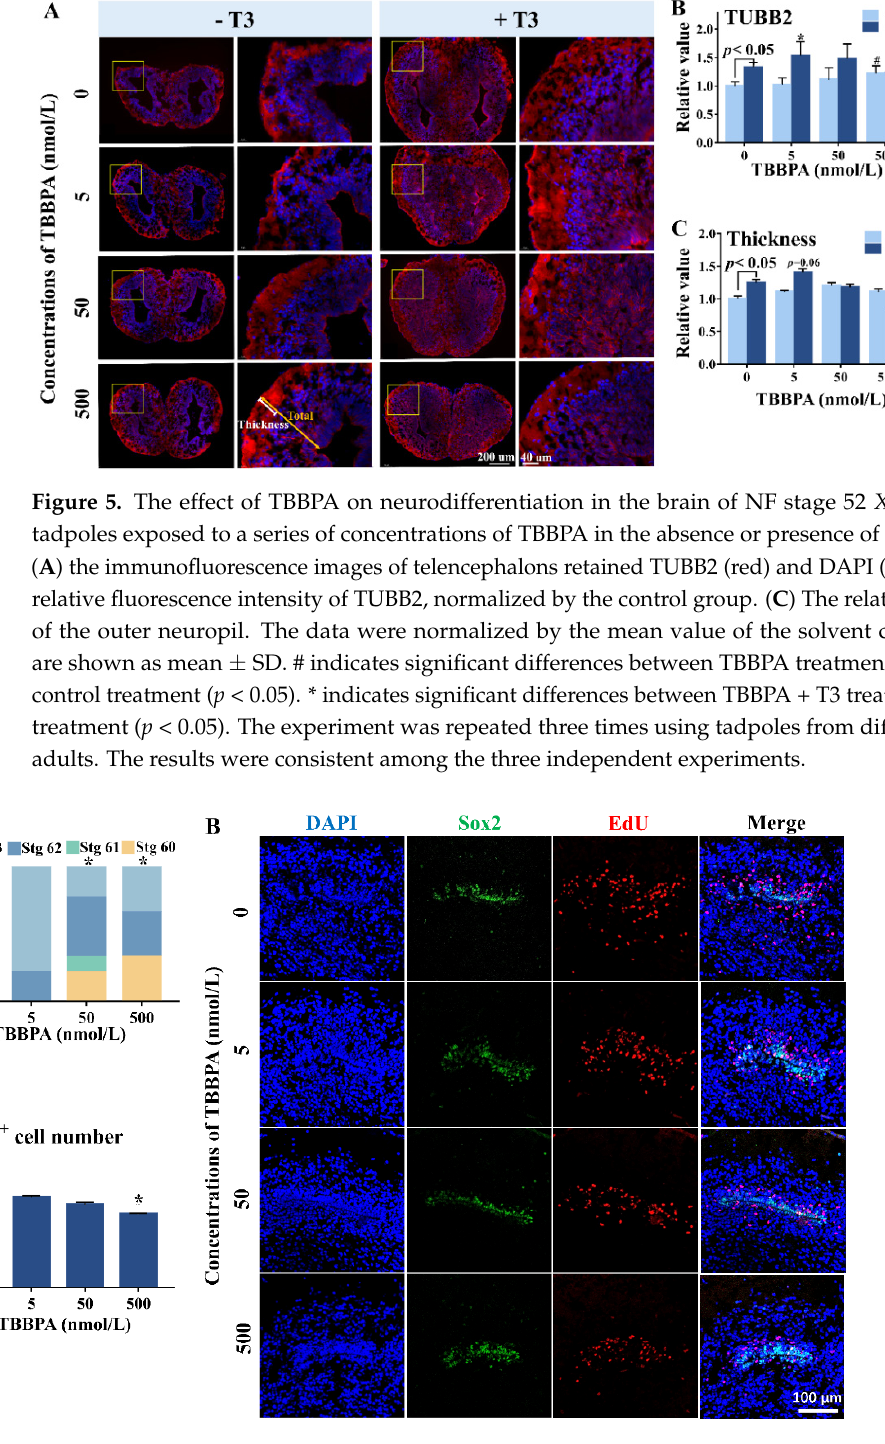
Figure 6. Effects of tetrabromobisphenol A (TBBPA) on spontaneous metamorphosis of Xenopus laevis at the metamorphic climax. ( A ) Percentages of tadpoles at different stages after a six-day exposure. * indicates a significant difference between TBBPA treatment and the solvent control group ( p < 0.05). ( B ) Immunofluorescence images for telencephalons of NF 63 tadpoles. EdU labeled proliferating cells and migrating cells. Sox2 outlined the ventricle zone. ( C ) The ratio of EdU positive cells number. The data were normalized by the mean value of the solvent control tadpoles. * indicates a significant difference between TBBPA treatment and the solvent control group ( p < 0.05).